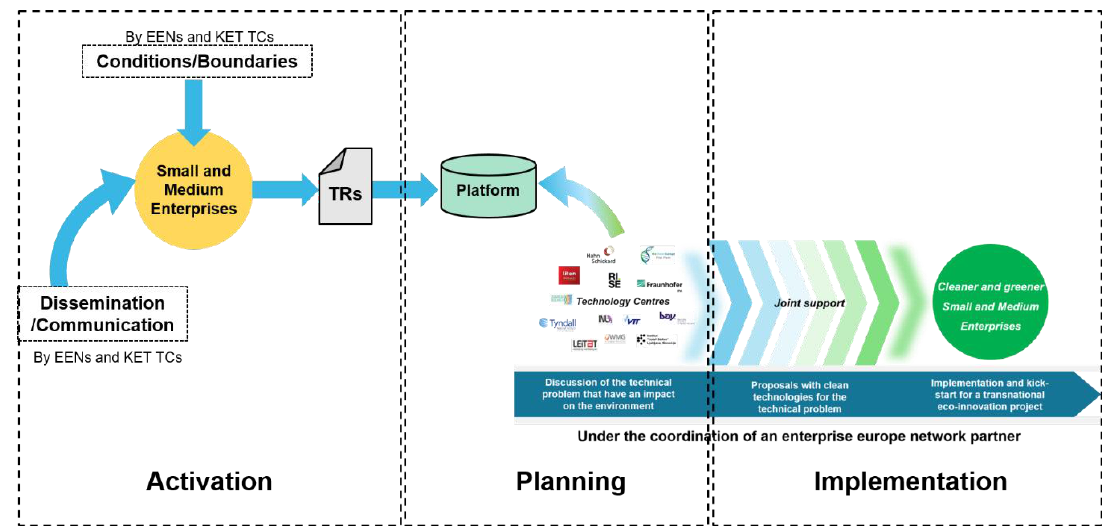
Figure 7. Whole open-eco-innovation process with KET TCs, SMEs, and EENs.